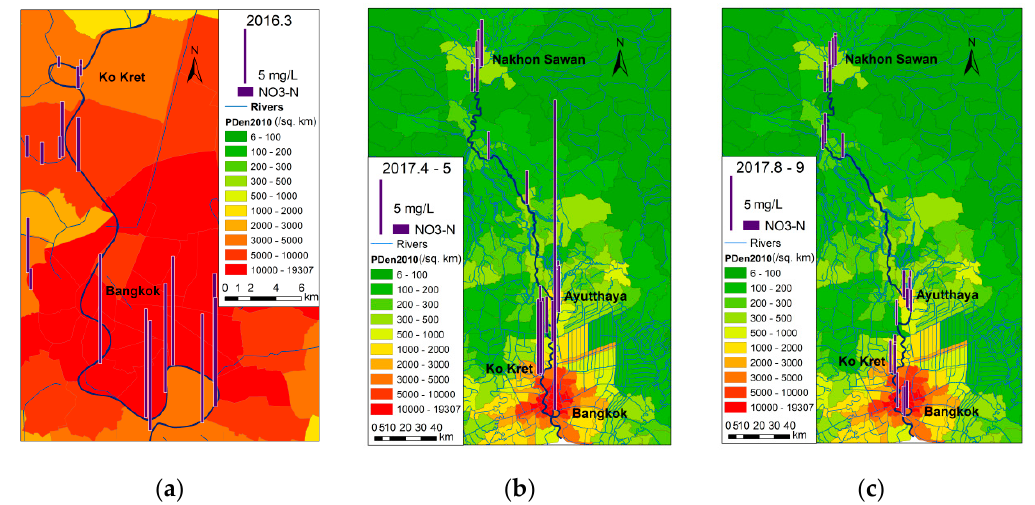
Figure 4. The spatial–temporal variation of NO 3 -N. ( a ) Dry season; ( b ) Beginning of the wet season; ( c ) Second half of the wet season.